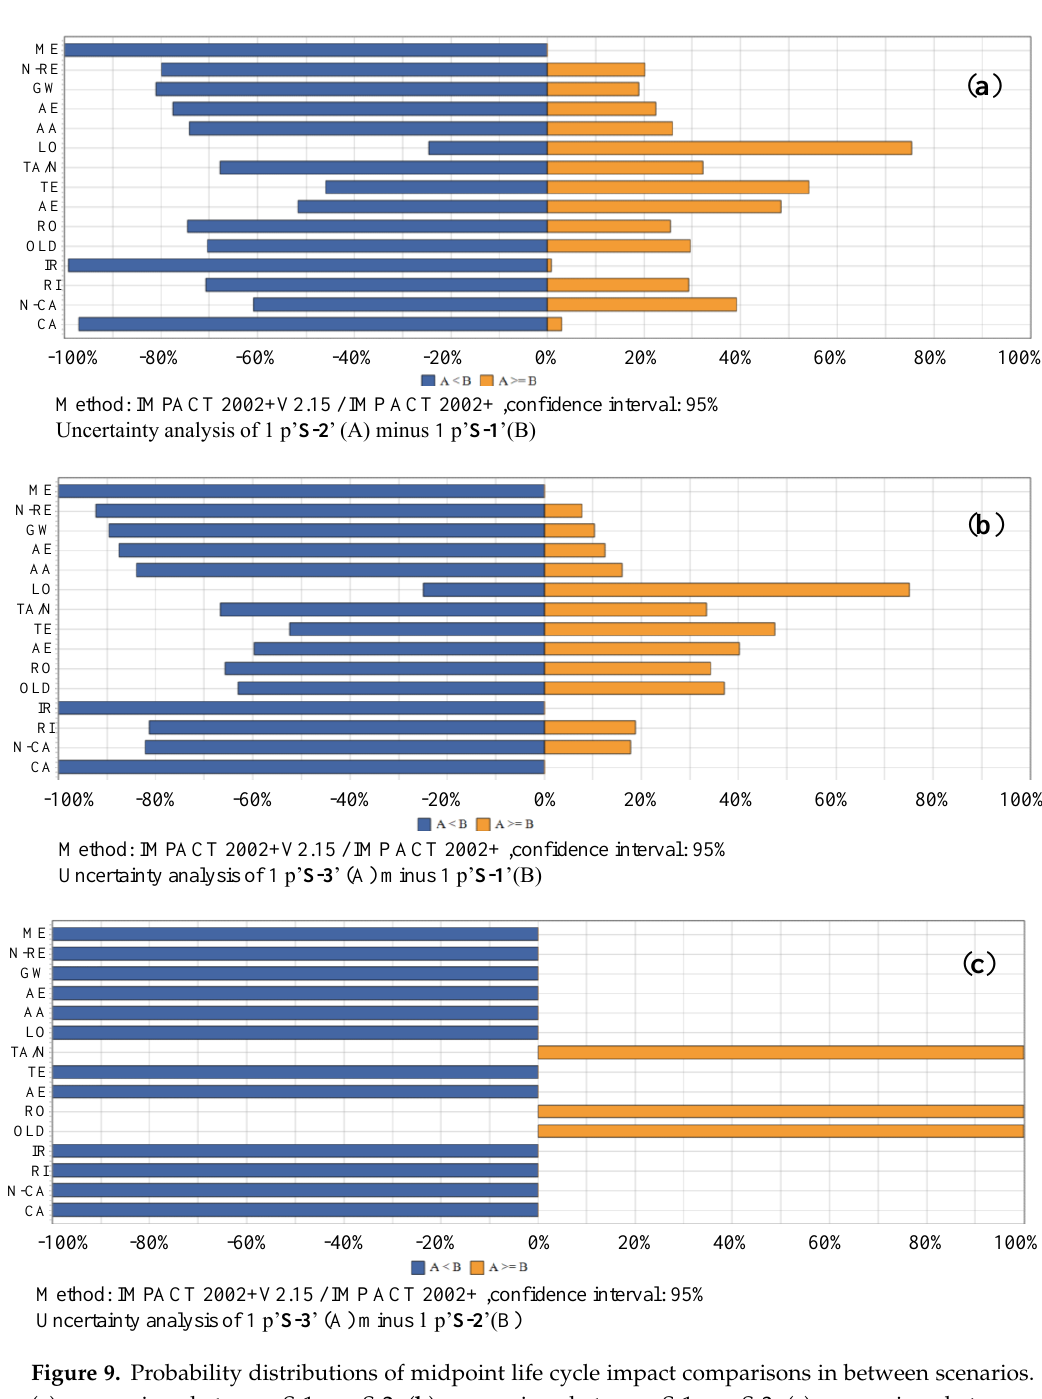
Figure 9. Probability distributions of midpoint life cycle impact comparisons in between scenarios. ( a ) comparison between S−1 vs. S−2, ( b ) comparison between S−1 vs. S−3, ( c ) comparison between S−2 vs. S−3. Notes: with confidence interval of 95%, simulated by Monte Carlo sampling, 10,000 runs. CA, climate change; N-CA, non-carcinogens; RI, respiratory inorganics; IR, ionizing radiation; OD, ozone layer depletion; RO, respiratory organics; AEC, aquatic ecotoxicity; TE, terrestrial ecotoxicity; TA, terrestrial acid / nutri; LO, land occupation; AA, aquatic acidification; AEU, aquatic eutrophication; GW, global warming; N-R, non-renewable energy; and, ME, mineral extraction; IMPACT, Impact Assessment of Chemical Toxics; S,